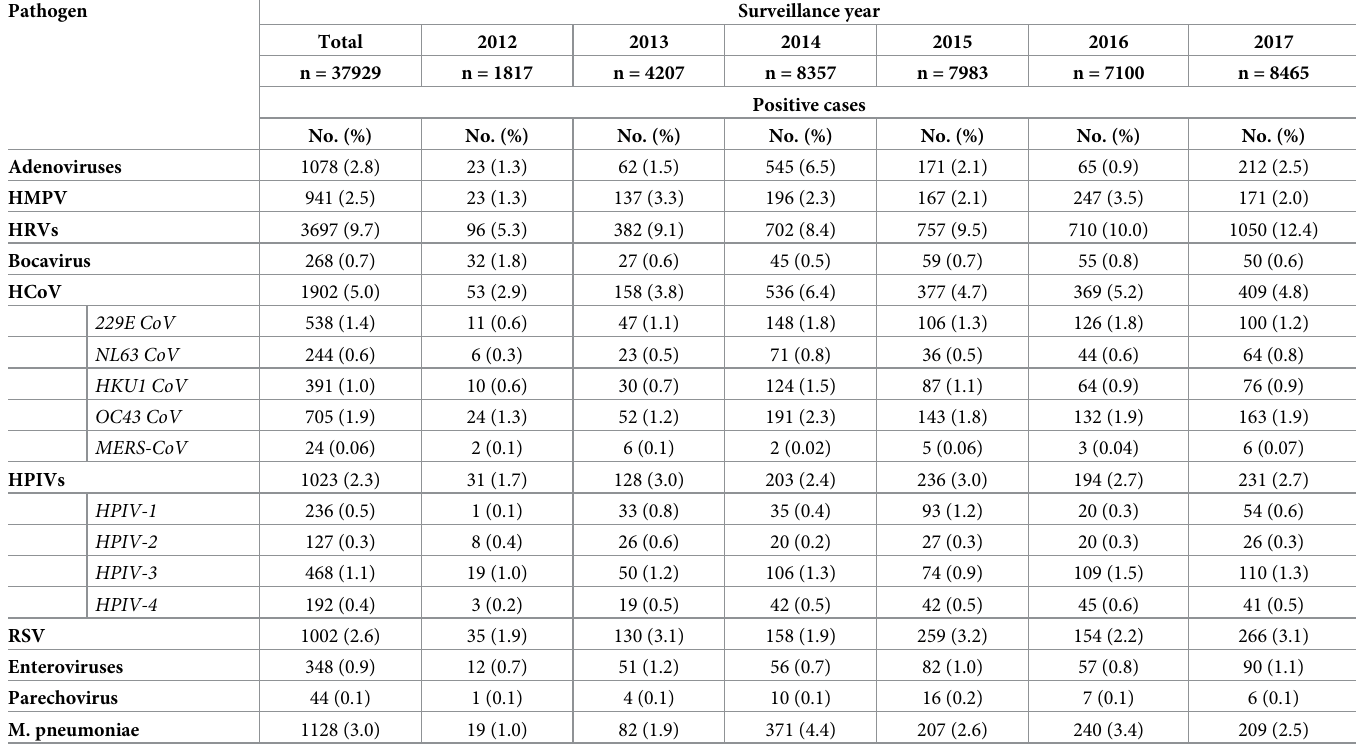
Table 3. Distribution of different respiratory pathogens by year of